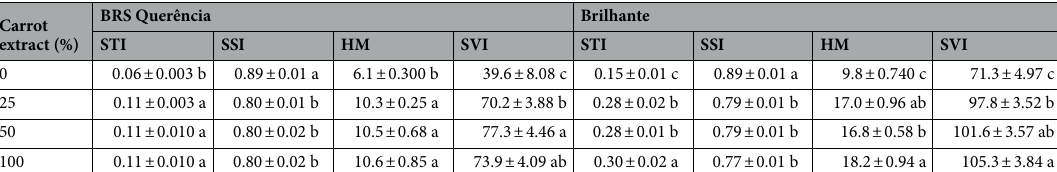
Table 3. Stress tolerance index (STI), stress susceptibility index (SSI), harmonic mean (HM), and seedling vigor index (SVI) of two rice cultivars, BRS Querência and Brilhante, in response to the conditioning of the seeds in the extract of carrot and the low germination temperature. Means followed by the same letter in the column do not differ from each other by the Tukey’s test (P ≤ 0.05). ± SD standard deviation.